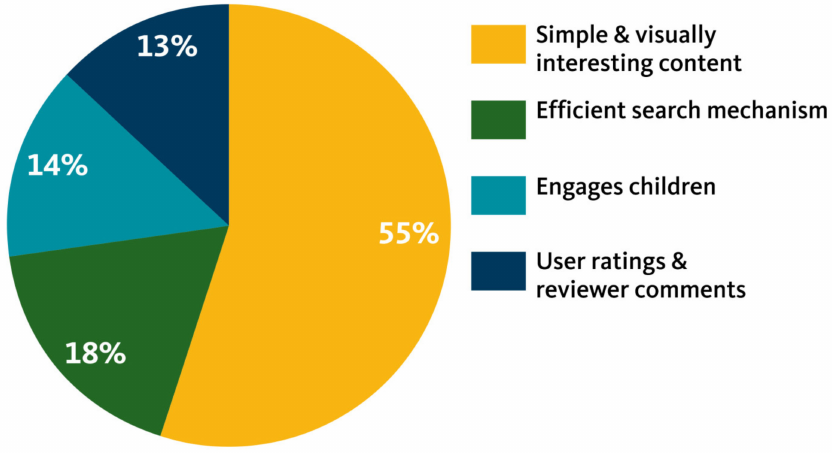
Figure 3. Characteristics desired in a recipe